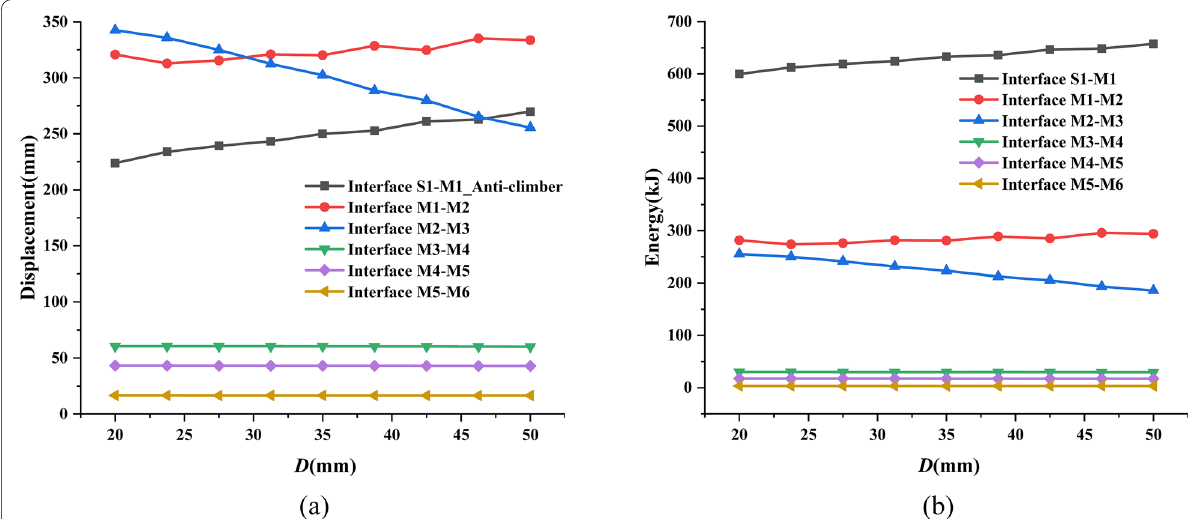
Figure 5 Influence of the empty stroke D on the collision response of the energy-absorbing devices: a compression displacement versus time curves, and b energy absorption versus time